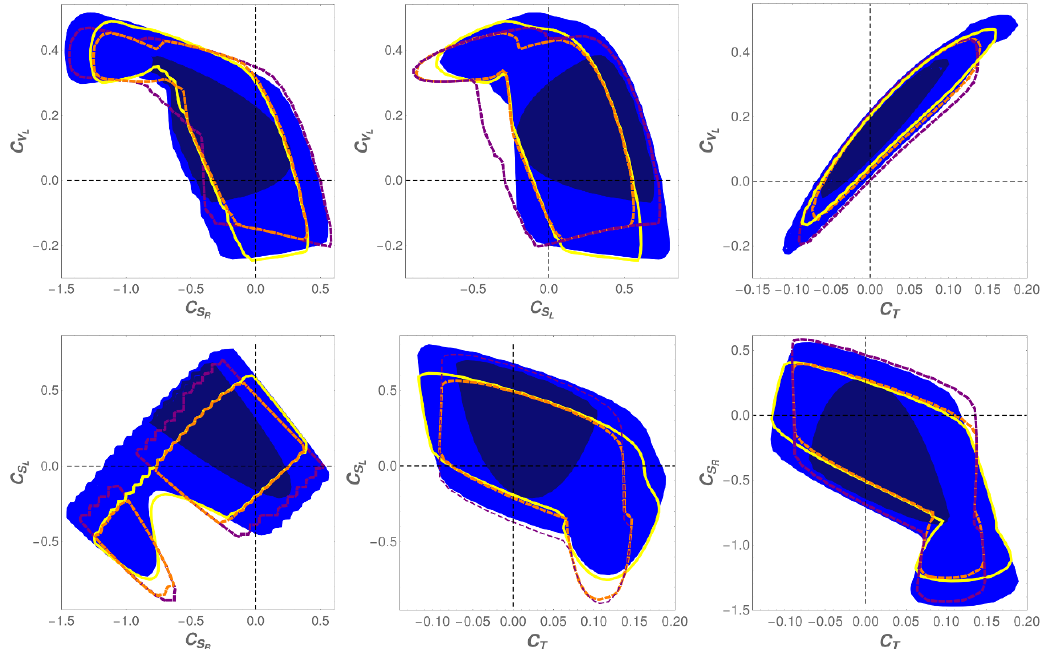
Figure 3 . Allowed regions for all possible combinations of two Wilson coe(cid:14)cients for di(cid:11)erent scenarios: blue areas (lighter 95% and darker 68% CL) show the minima without F D (cid:3) ( B c (cid:28) (cid:22) (cid:23) (cid:28) ) 30%. The yellow lines display how the 95% CL bounds change when B ! (cid:20) 10%. The dashed lines show the e(cid:11)ect of adding the observable F D (cid:3) (purple) and for ( B c (cid:28) (cid:22) (cid:23) (cid:28) ) 10% B ! (cid:20)